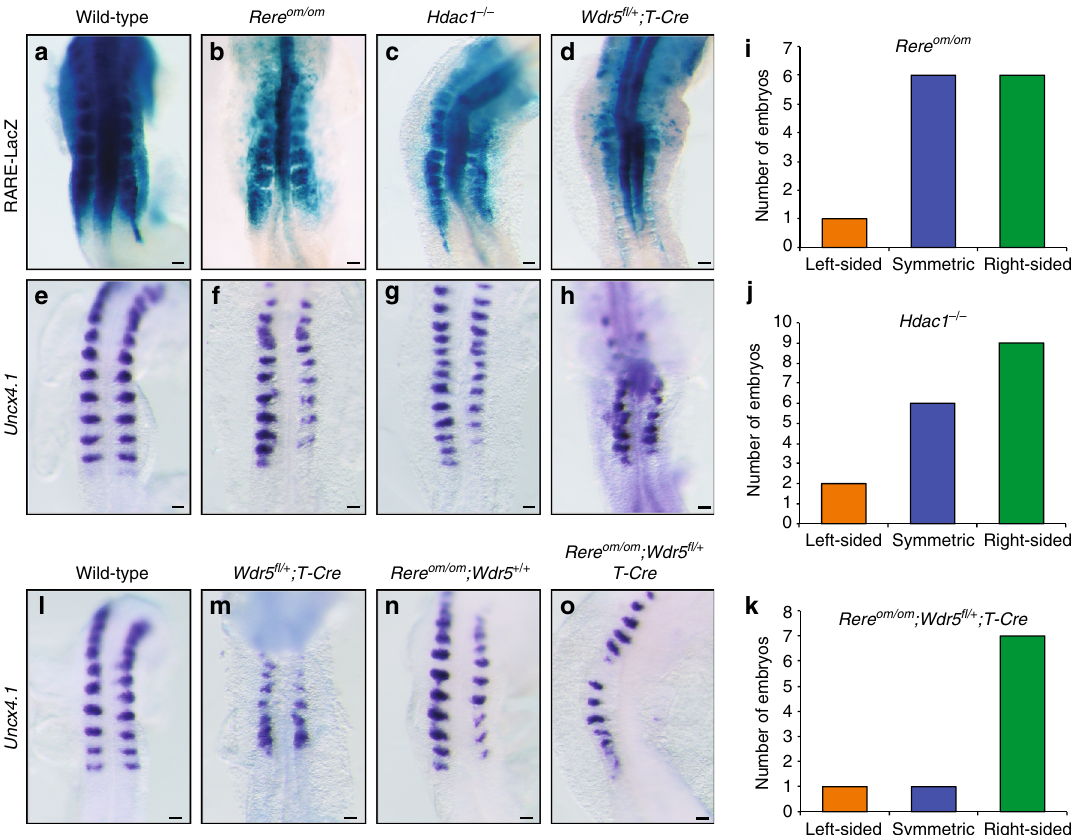
Fig. 3 The WHHERE complex controls somite bilateral symmetry. a – d RARE-LacZ expression in wild-type a , Rere om/om b , Hdac1 − / − c and Wdr5 fl / + ; T-Cre d embryos at E8.75-E9.0 ( dorsal views ). e – h In situ hybridization showing somites labeled with Uncx4.1 in wild-type e , Rere om/om f , Hdac1 – / – g and Wdr5 fl / + ; T-Cre h embryos at E8.75-E9.0 ( dorsal views ). i – k Graphs representing the number of 7- somite to 15-somite stage embryos with left-sided ( orange ), symmetric ( blue ) or right-sided ( green ) delay in somite formation: Rere om/om i , Hdac1 – / – j and Rere om/om ;Wdr5 fl / + ;T-Cre k . l – o In situ hybridization for Uncx4.1 in wild-type l , Wdr5 fl / + ;T-Cre m , Rere om/om ;Wdr5 + / + n and Rere om/om ;Wdr5 fl / + ;T-Cre o embryos at E8.75-E9.0 ( dorsal views ). For each genotype at least 5 – 10 embryos were analyzed. Bar = 100